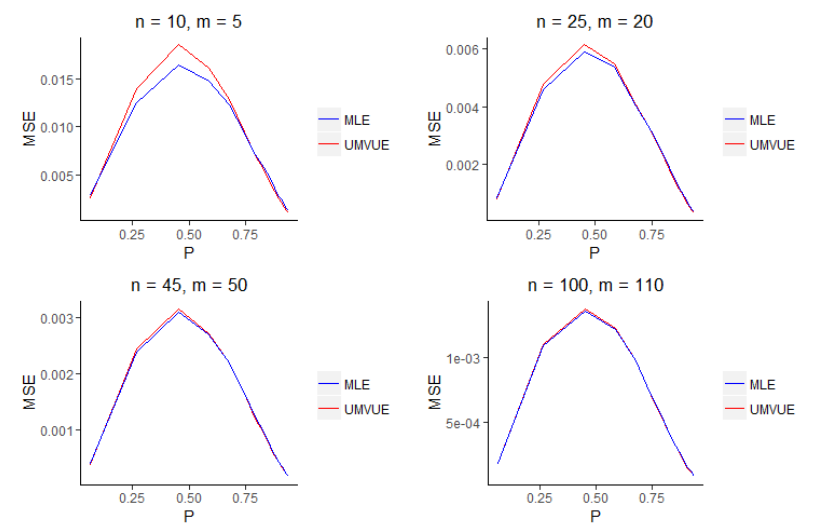
Figure 5 – MSE of the UMVUE and MLE of P for different sample sizes.